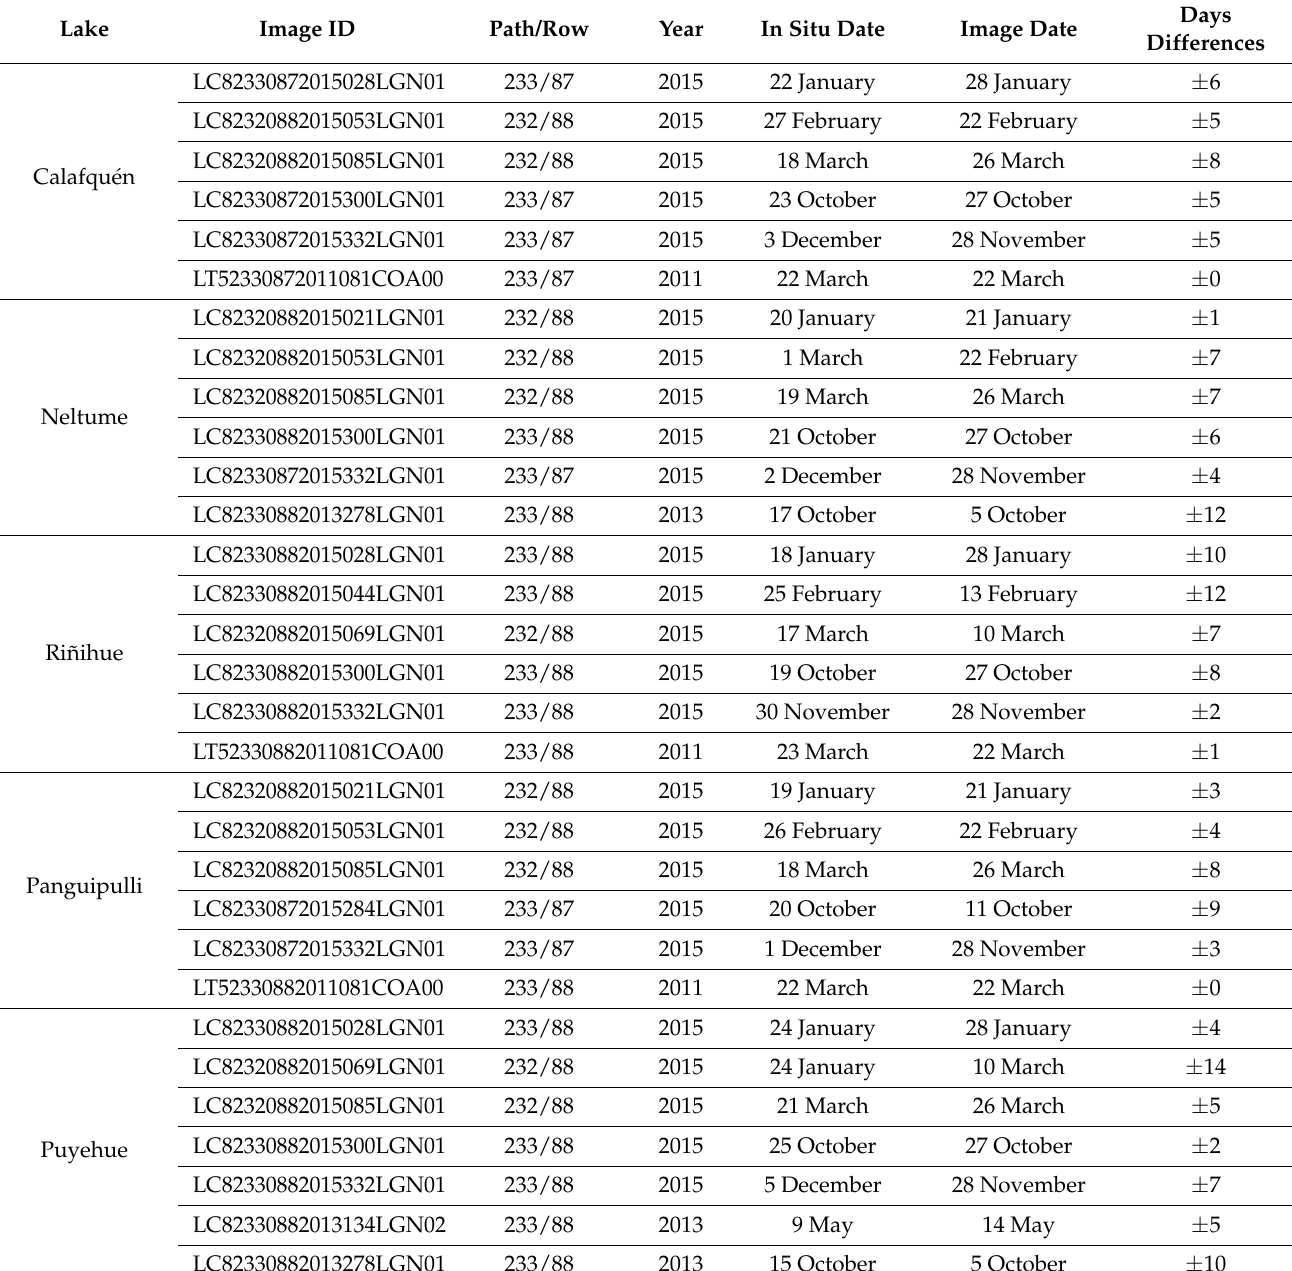
Table 2. Landsat image characteristics and in situ